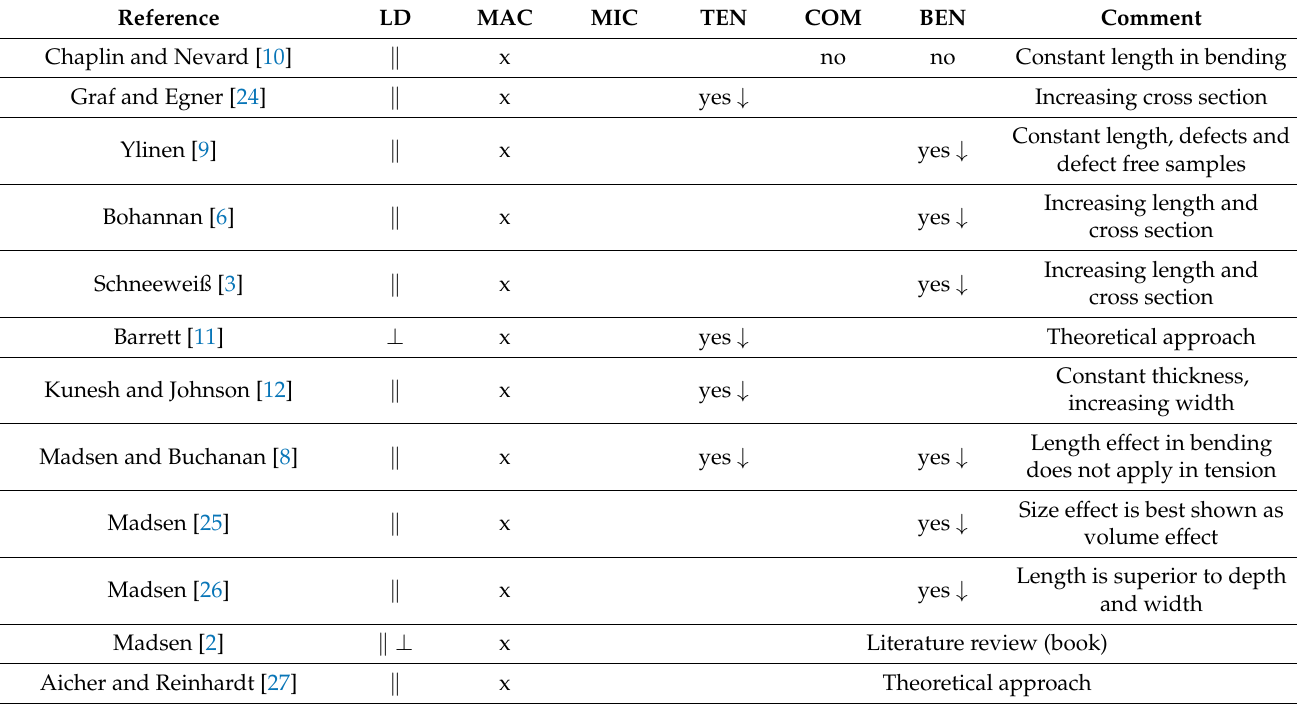
Table 1. Chronological overview of the literature investigating the size effect on the mechanical performance of wood and if a size effect was reported (yes) or not (no). (LD = Load direction: Parallel to the grain = (cid:107) and Perpendicular to the grain = ⊥ ; size scale: MAC = Macroscopic, MIC = Microscopic; Load cases: TEN = Tension, COM = Compression and BEN = Bending; ↓ : strength decreases with increasing size; and ↑ : strength increases with increasing